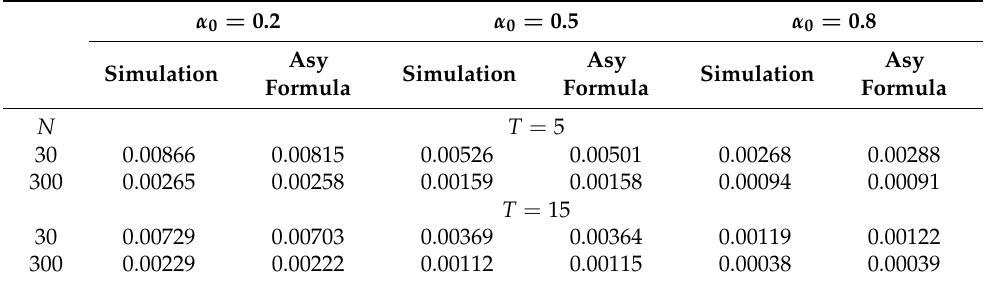
Table 2. The RMSE of FOSLS calculated by simulation and asymptotic formula (9) for nonnormal- nonstationary scenario.